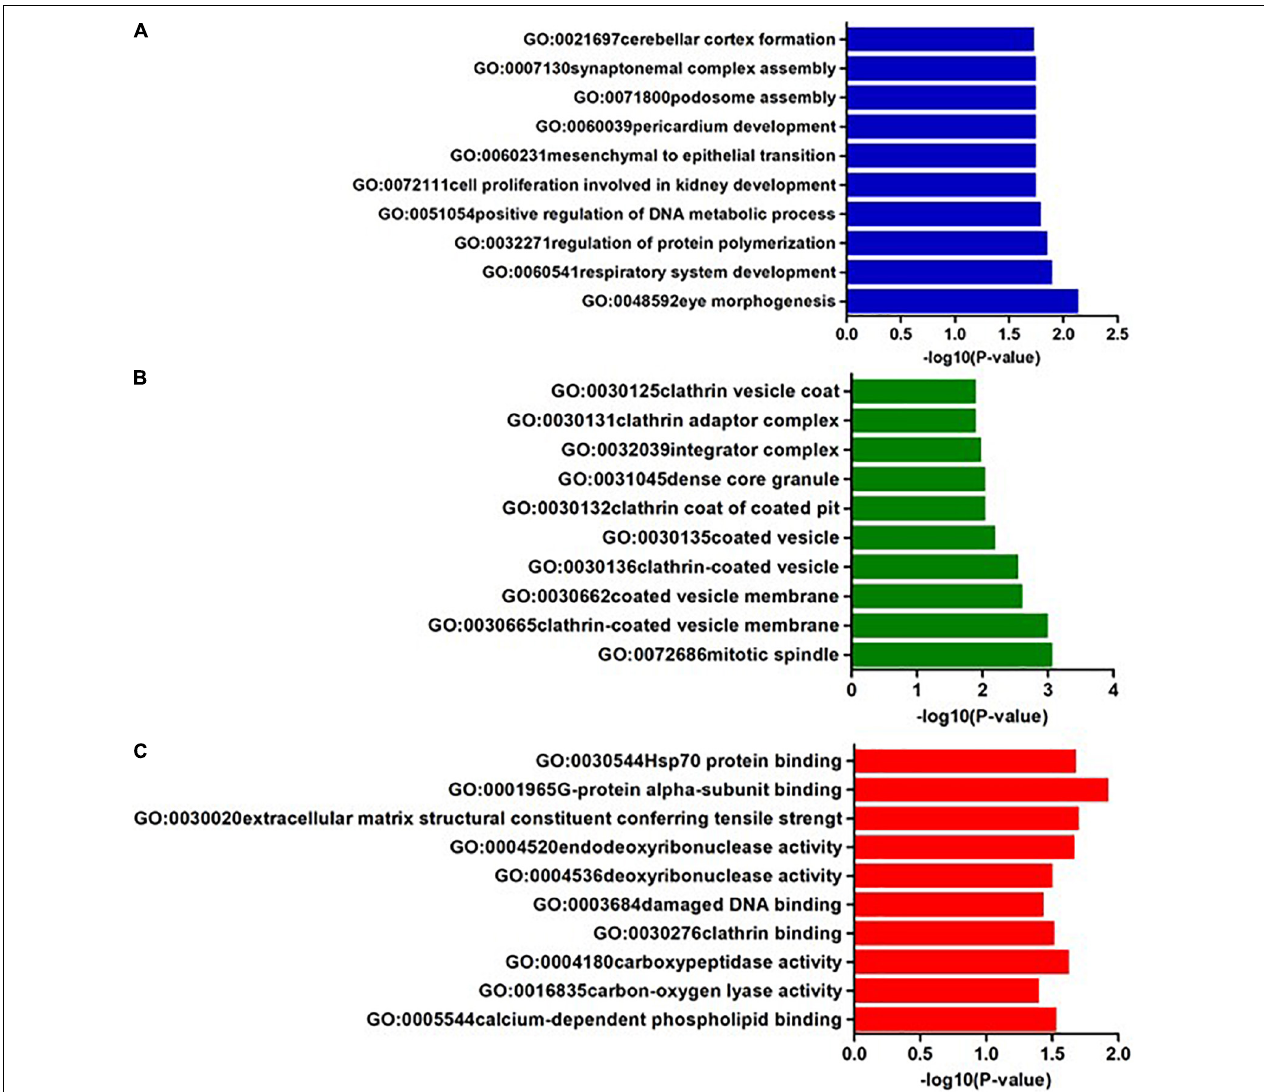
FIGURE 5 | The top ten GO annotations of AQP4- negative NMOSD, (A) is for biological process, (B) is for molecular function, and (C) is for cellular